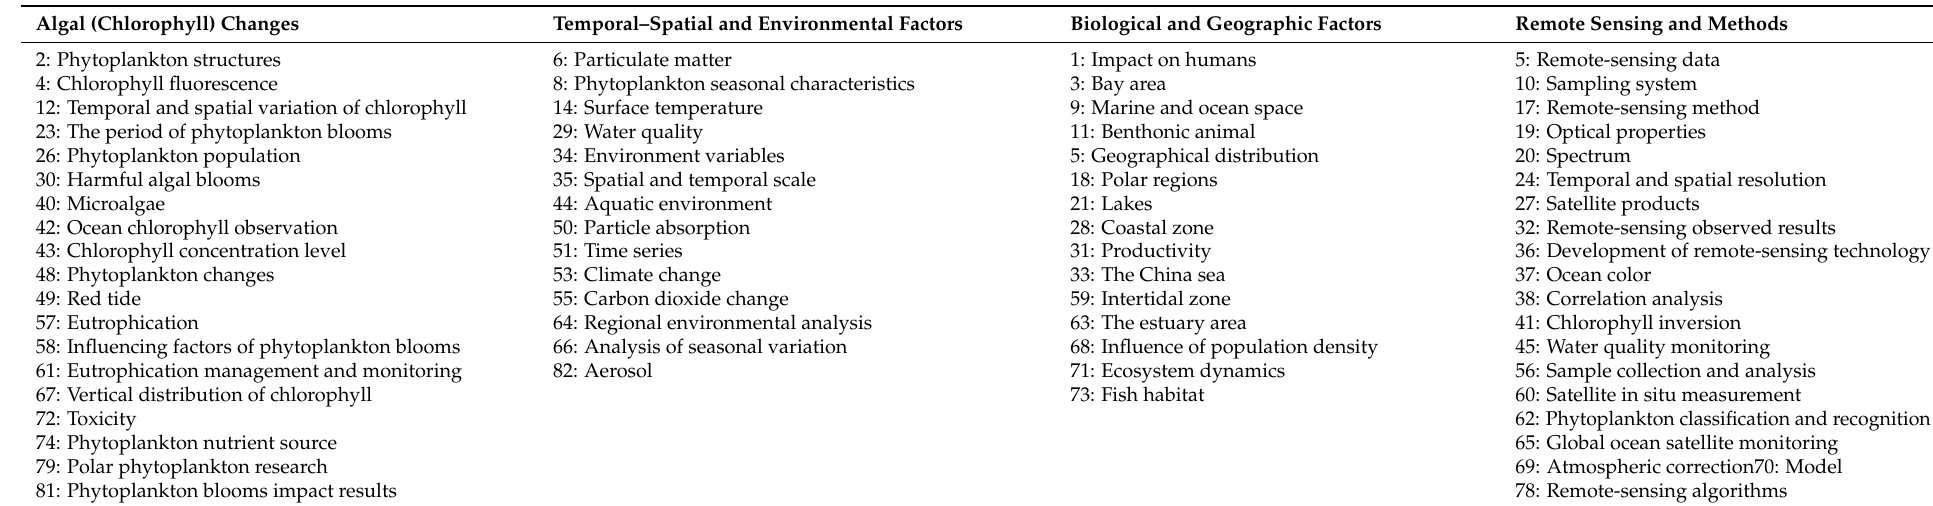
Table 4. Subject classification (the numbers in the table only represent the numbers assigned to each